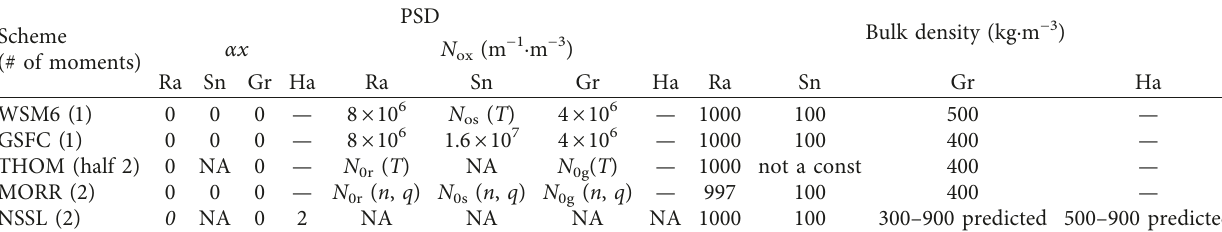
Table 1: Particle-size distribution (PSD) and density assumptions for precipitation hydrometeor species. Scheme